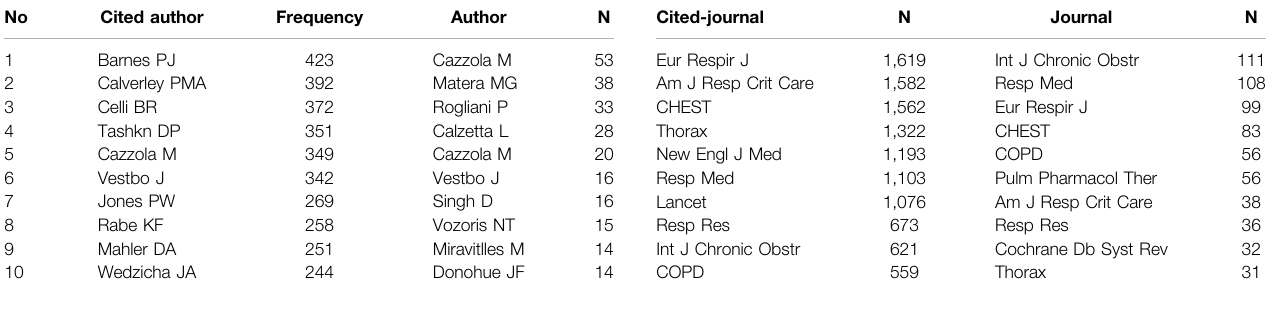
TABLE 2 | The top 10 authors with the highest citations of COPD drugs-related studies from 1980 to 2021.